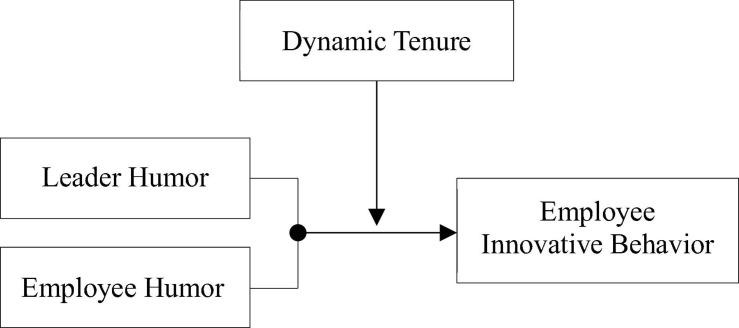
Hypothesized model.